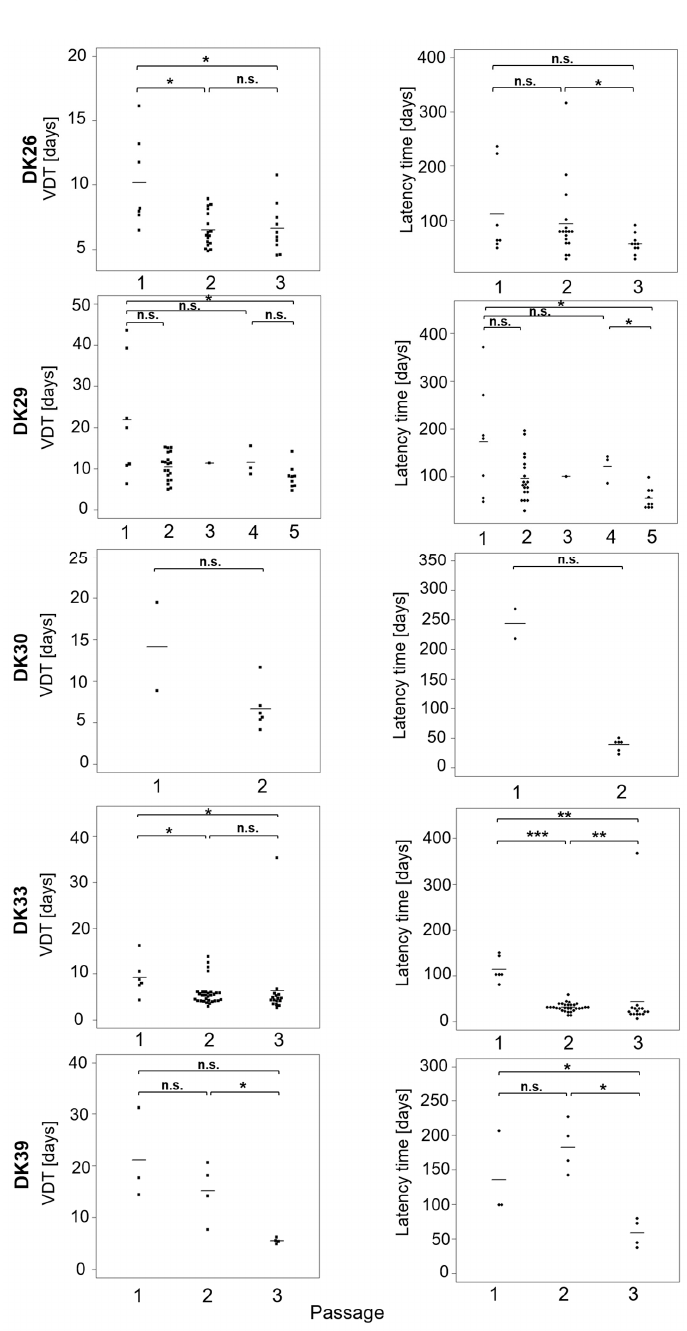
Figure 3. Volume doubling time and latency time in the subsequent passages. For each 1